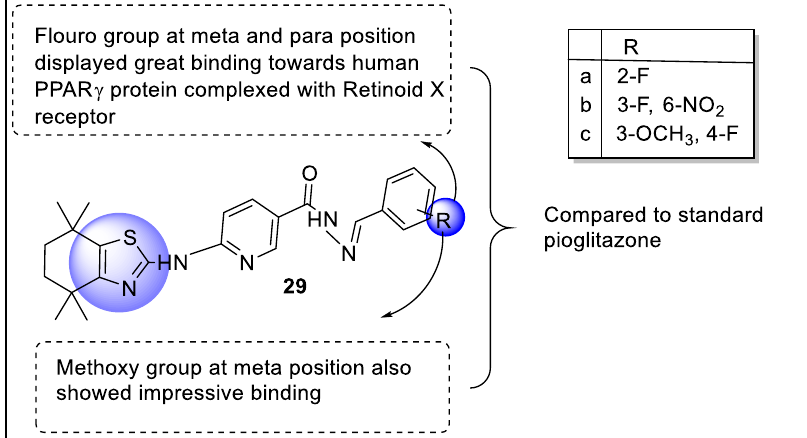
Figure 33. Structural activity relationship of thiazole hybrids ( 29 ) as potent PPAR